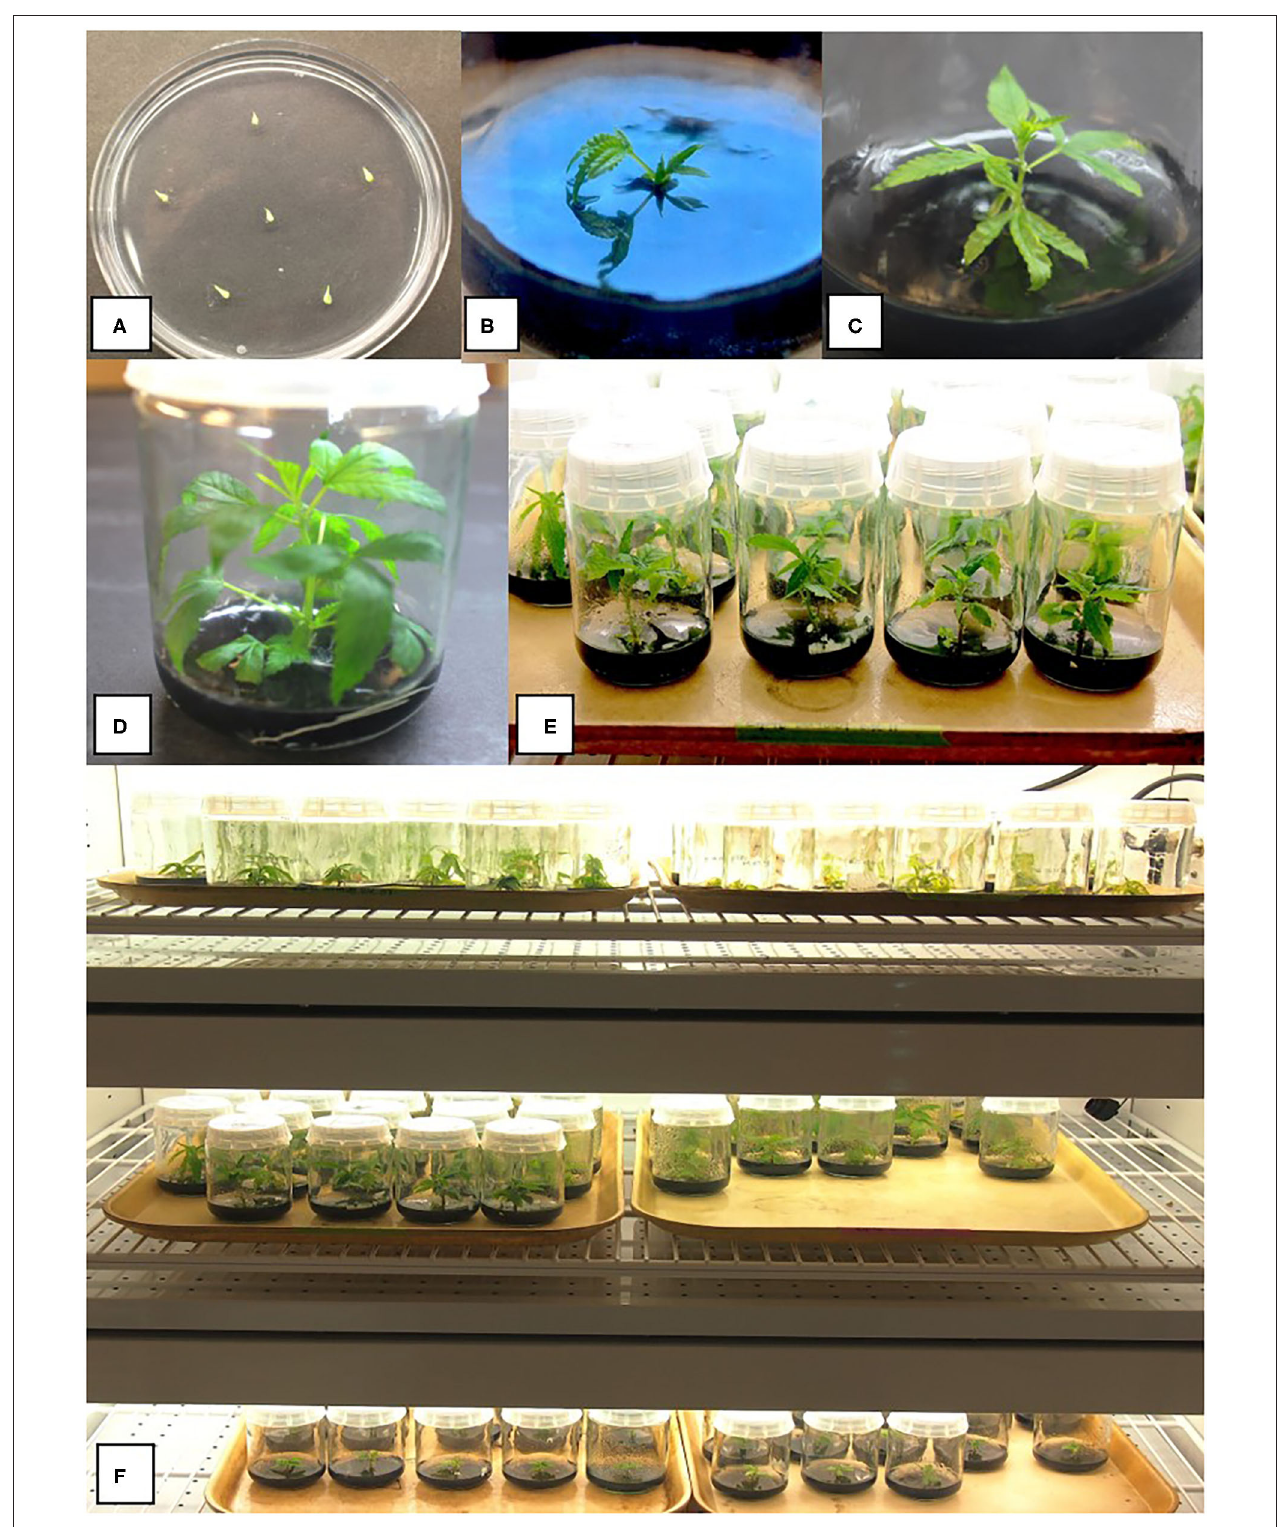
FIGURE 1 | Various stages of growth of shoots derived from meristems of drug-type cannabis genotypes grown on a multiplication medium (MM) containing activated charcoal. (A) Meristem explants placed on an agar medium in a 90-mm Petri dish to show their small size. (B) Early shoot growth after 4 weeks in culture from a meristem. (C) Shoot growth after 8 weeks. (D,E) Shoot growth after 10 weeks from meristems. (F) Baby food jars containing meristem explants at different stages of development in a controlled environment growth chamber. A number of different strains are shown. Conditions of incubation are described in the Methods section.